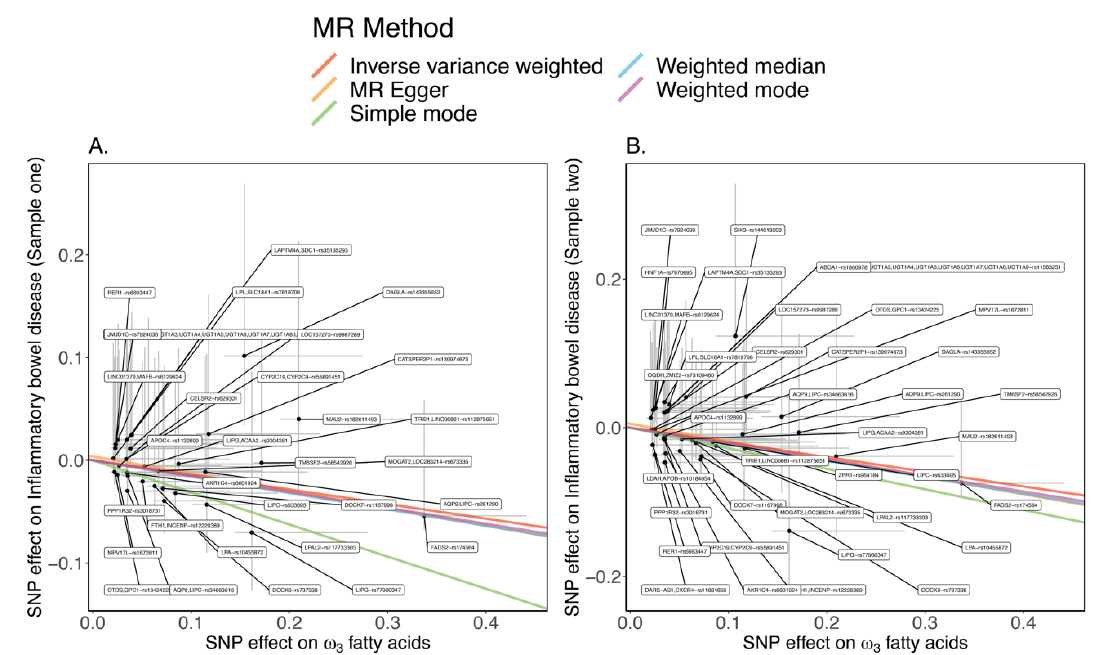
Figure 1. ( A ) Slopes representing the causal association for each MR method for ω 3 fatty acids on the Sample one IBD GWAS. ( B ) Slopes representing the causal association for each MR method for ω 3 fatty acids on the Sample two IBD GWAS. Each point is labeled with the SNP and nearby gene(s). When removing the SNPs with an F-statistic < 10 in Sample one, the p -values remained in the range of 10 − 5 < p < 10 − 2 with ORs less than 1.0. By Fisher’s method for combining p -values from all three samples, all MR modes were significant at p < 0.0001, except for the simple mode ( p < 0.01). Full summary statistics of each MR method are shown in Table 1. Table 1. MR results for ω 3 fatty acid IVs on IBD (Samples one, two, and three).